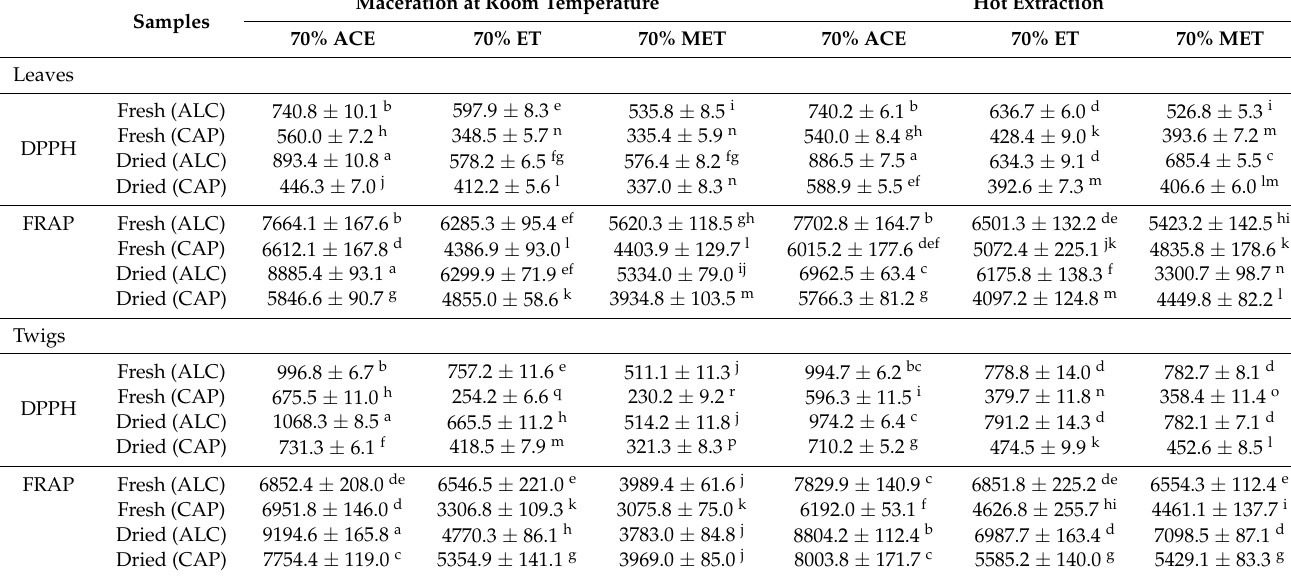
Table 2. Results from DPPH (mg TE/g extract) and FRAP (mmol Fe 2+ /g extract) of extracts from fresh and dried leaves and twigs from Alcobaça (ALC) and Caparica (CAP), using different extraction solvents and extraction methods; DPPH and FRAP results expressed relative to the mass of biomass are presented in Supplementary Material, Table S1